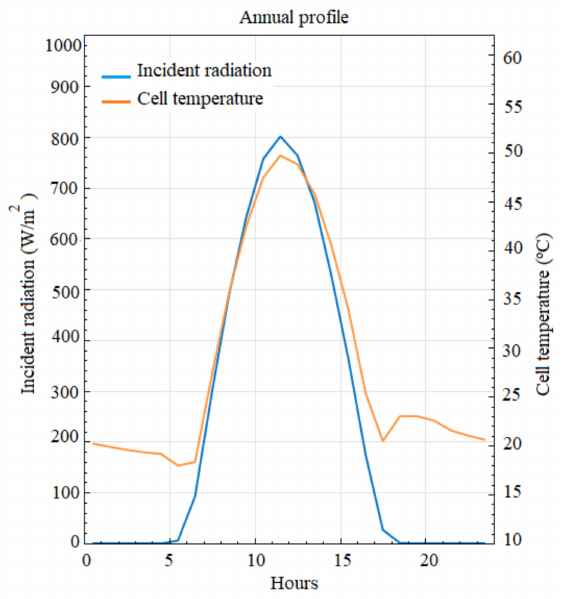
Figure 18. Relation between the cell temperature and incident radiation (tilt angle = 23 ◦ and azimuth angle = 11 ◦ ).